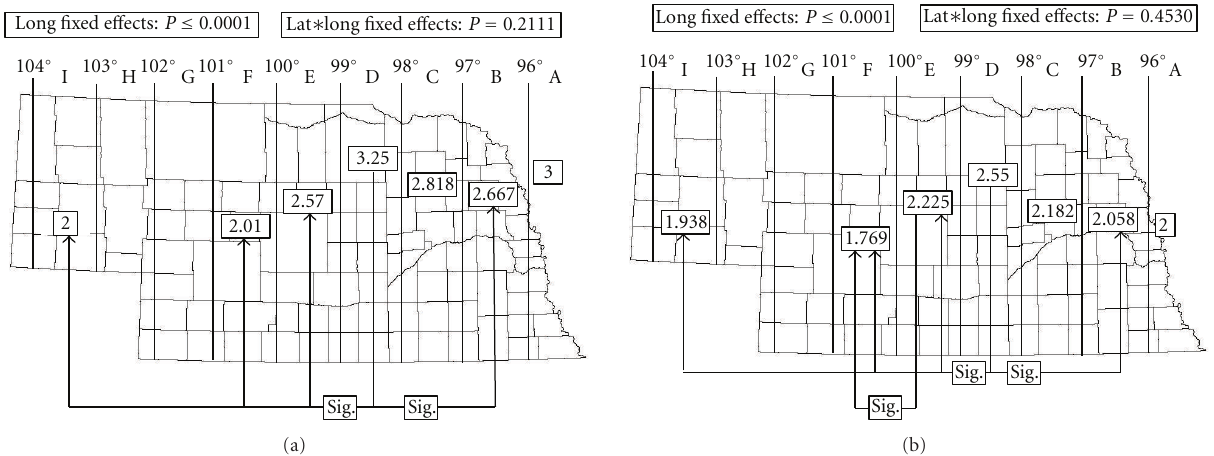
Figure 3: Elytral maculation character states for C. splendida (adapted from [18]). (a) Middle band and (b) apical lunule. Total maculation and humeral lunule not presented as no significant di ff erences found. Significant di ff erences between longitudes shown by arrows and mean value presented in each longitudinal grouping. Fixed e ff ects and e ff ects of latitude by longitude interactions presented at top of each map.